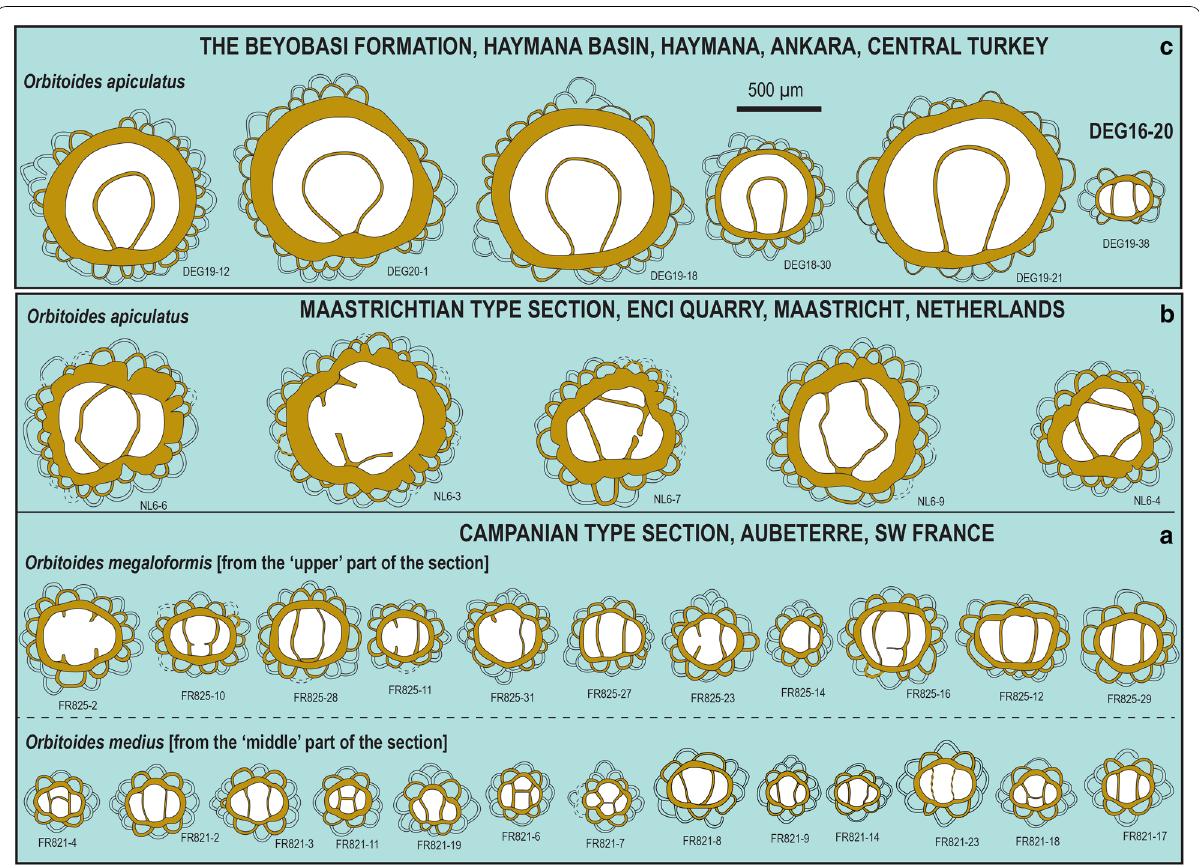
Fig. 8 Line drawings of the embryonic-nepionic stages of Orbitoides from the Campanian ( a ) and Maastrichtian type sections (redrawn from van Hinte 1966b) ( b ) and from the upper Maastrichtian of the Haymana Basin (redrawn from Özcan and Özkan-Altıner 1997) ( c ). A stratigraphic column of the Campanian type section and positions of samples (abbreviated as FR) are given in van Hinte (1966b). Note the occurrence of specimens with ‘ O. medius ’ type embryonic apparatus associating with O. apiculatus in the upper Maastrichtian of the Haymana Basin (Central